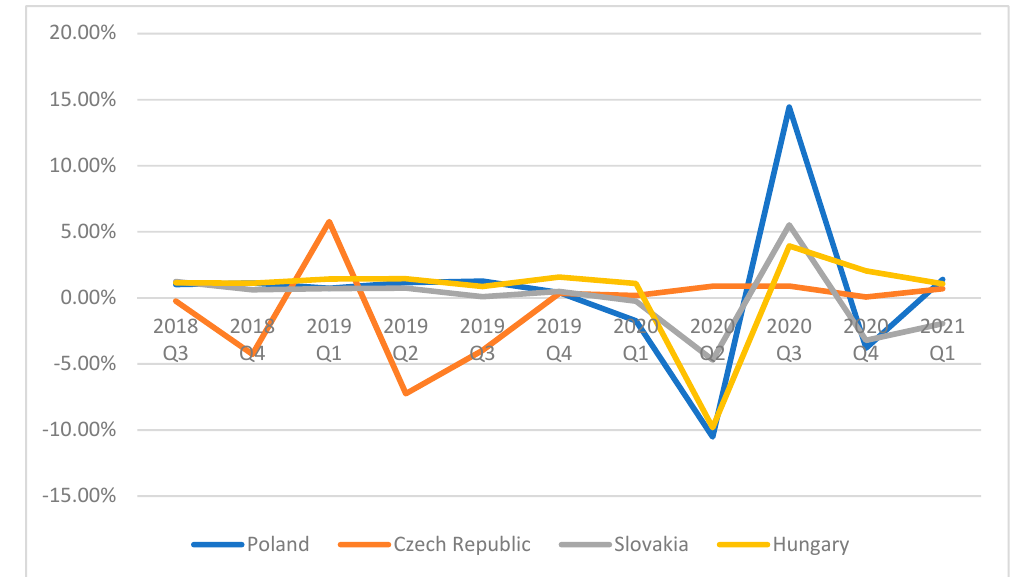
Figure 5. Household real final consumption expenditure (per capita) in selected CEE countries—growth rate compared to previous quarter. Source: (OECD Database 2021).